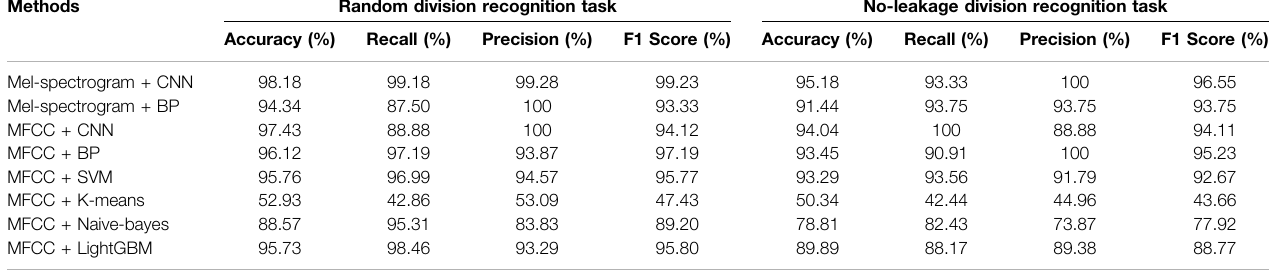
TABLE 1 | The comparison results of different methods. Methods